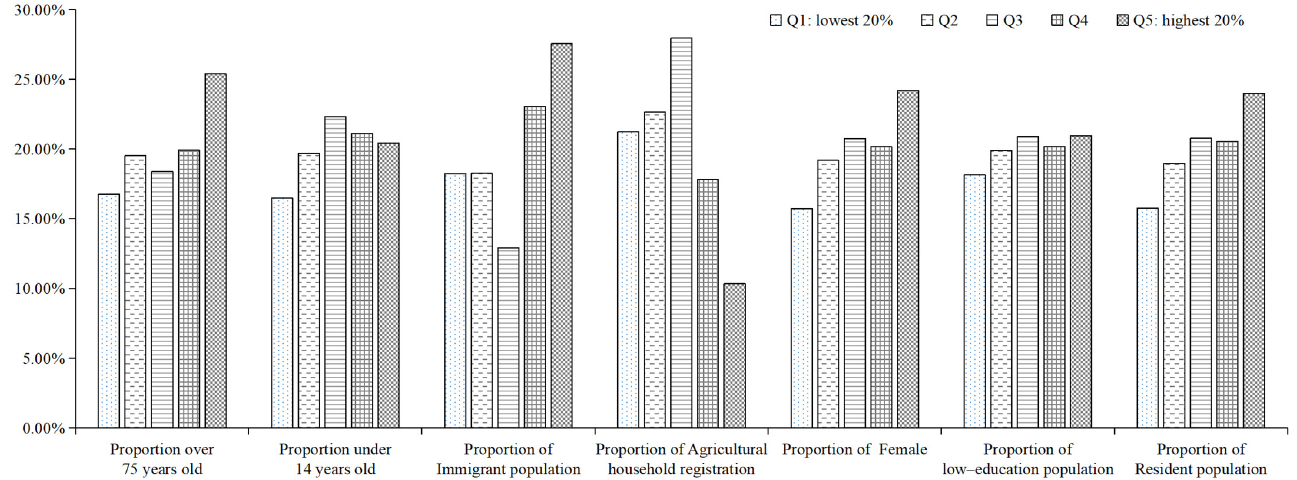
Figure 3. The proportion of six categories of vulnerable groups for the flooded proportion in Nan- jing.